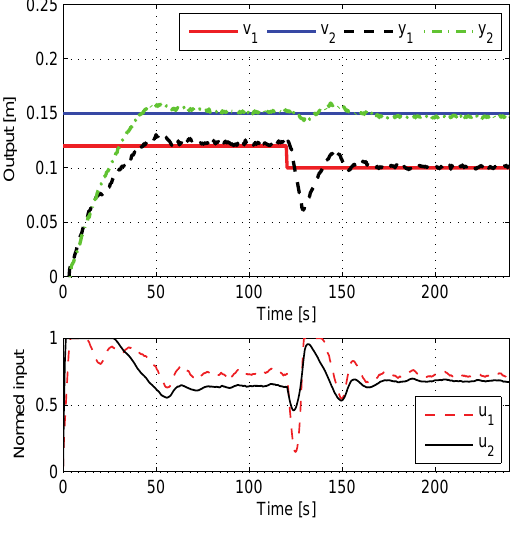
Fig. 8. The upper plot represents experimental results of water levels in the first and second tanks. The lower plot depicts the corresponding control